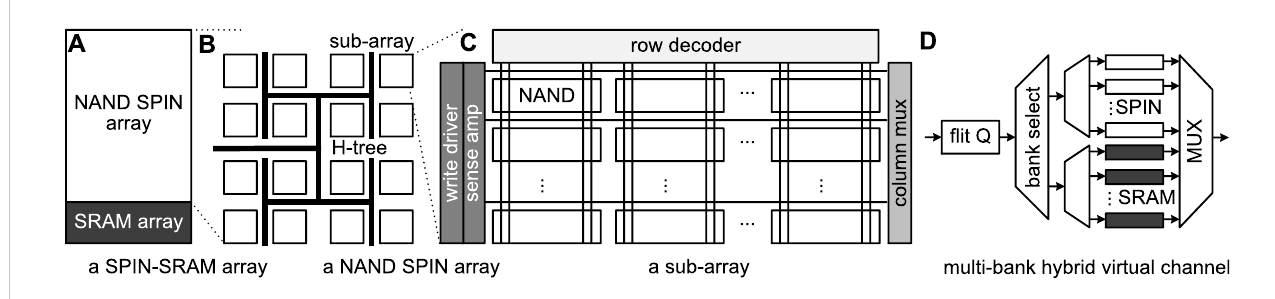
FIGURE 9 The SPIN-SRAM hybrid scratchpad memory and its hybrid NoC (A) :a SPIN-SRAM array; (B) :a NAND SPIN array; (C) :a sub-array; (D) :a multi-bank hybrid virtual